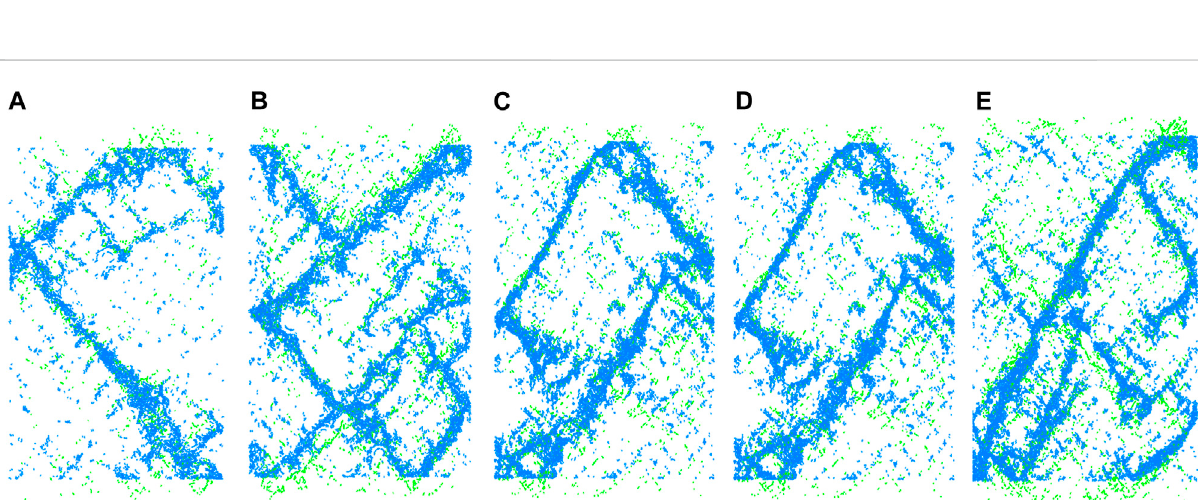
Frontiers in Earth